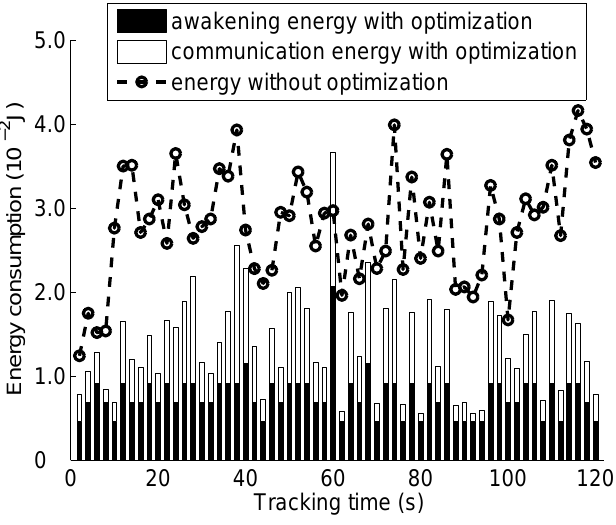
Figure 10 . Energy consumption of WSN in 60 tracking